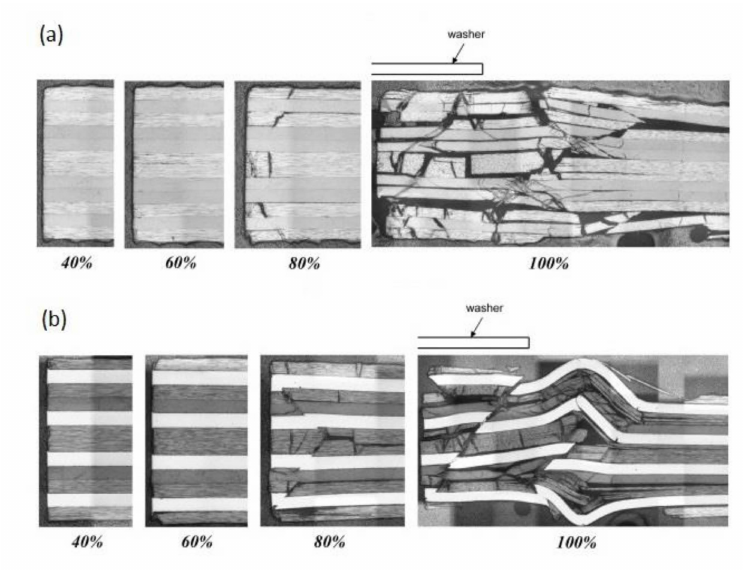
Figure 18. Micrographs of the bearing plane of ( a ) pure and ( b ) hybrid laminate at di ff erent percentages of the peak load [19].